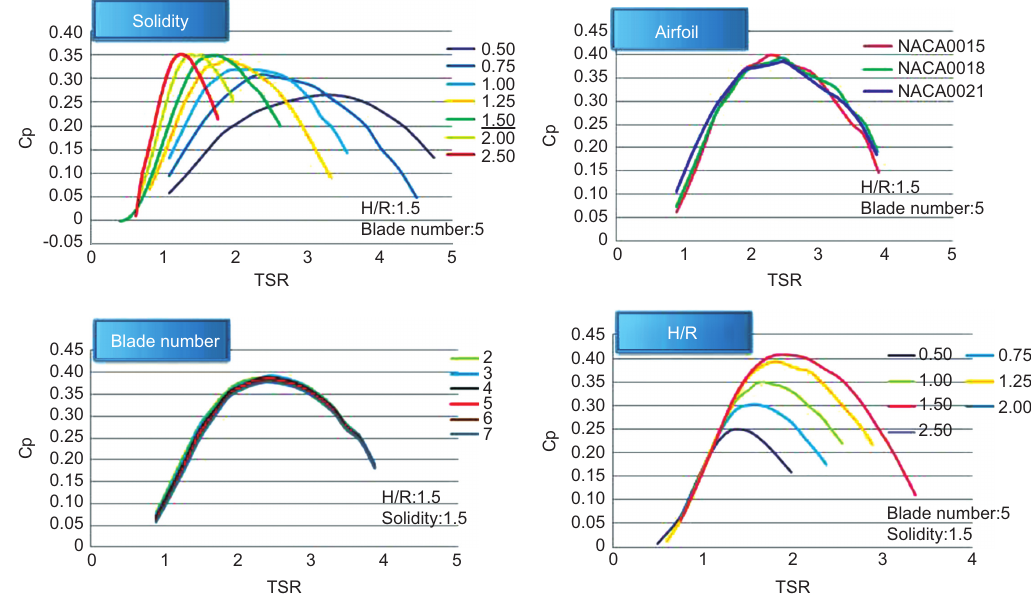
Figure 3 Comparison between the aerodynamic performance calculation results by the proposed and the test results of Uppsala University